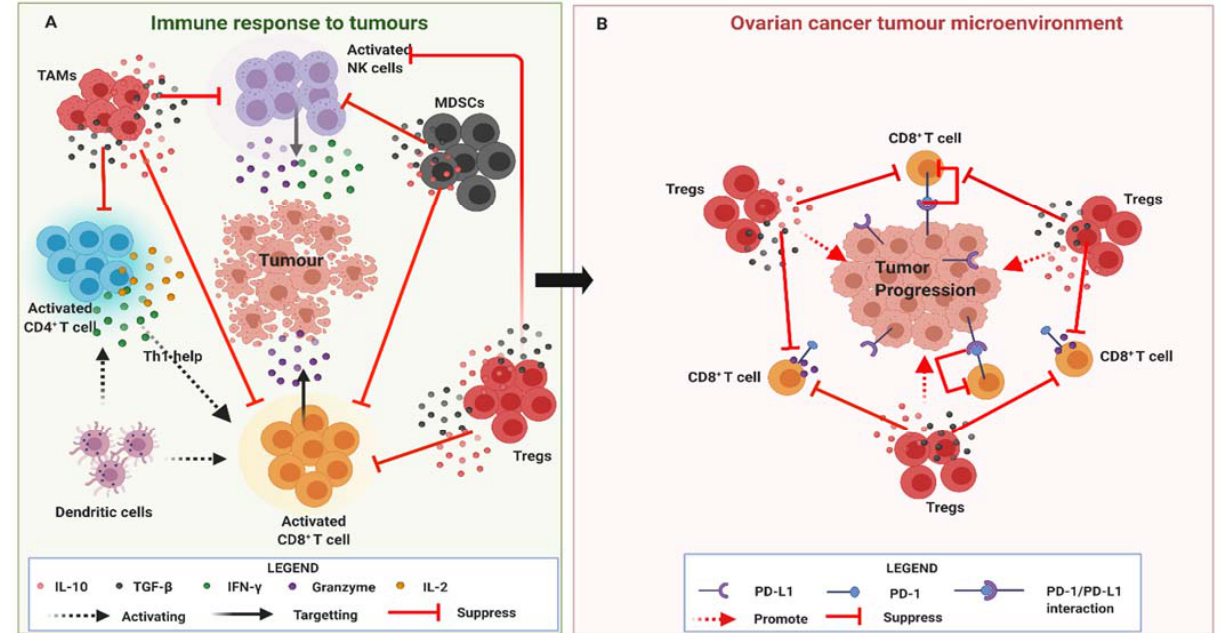
Figure 3. ( A )The human immune system harbours various immune cells such as natural killer (NK) cells, CD8 + T cells, CD4 + T helper cells and dendritic cells (DCs) that play an important role in controlling the developing tumour. DCs and CD4 + T cells via IL-2 and INF- γ secretion activate CD8 + cytotoxic T cells (CTLs) and NK cells which then produce toxic molecules such as granzymes that target the developing tumour. However, pro-tumour cells such as regulatory T cells (Tregs), myeloid-derived suppressor cells (MDSCs) and tumour-associated macrophages (TAMs) produce immunosuppressive cytokines (IL-10 and TGF- β ) that inhibit CDTLs and NK cells effector responses. ( B ). The ovarian cancer tumour microenvironment is commonly characterised by high frequencies of infiltrating Tregs and a high Tregs:CD8 + T cell ratio that promotes tumour progression. Ovarian tumour also expresses PD-L1 that further inhibits CD8 + T cell effector responses upon ligation with PD-1. Figure created with